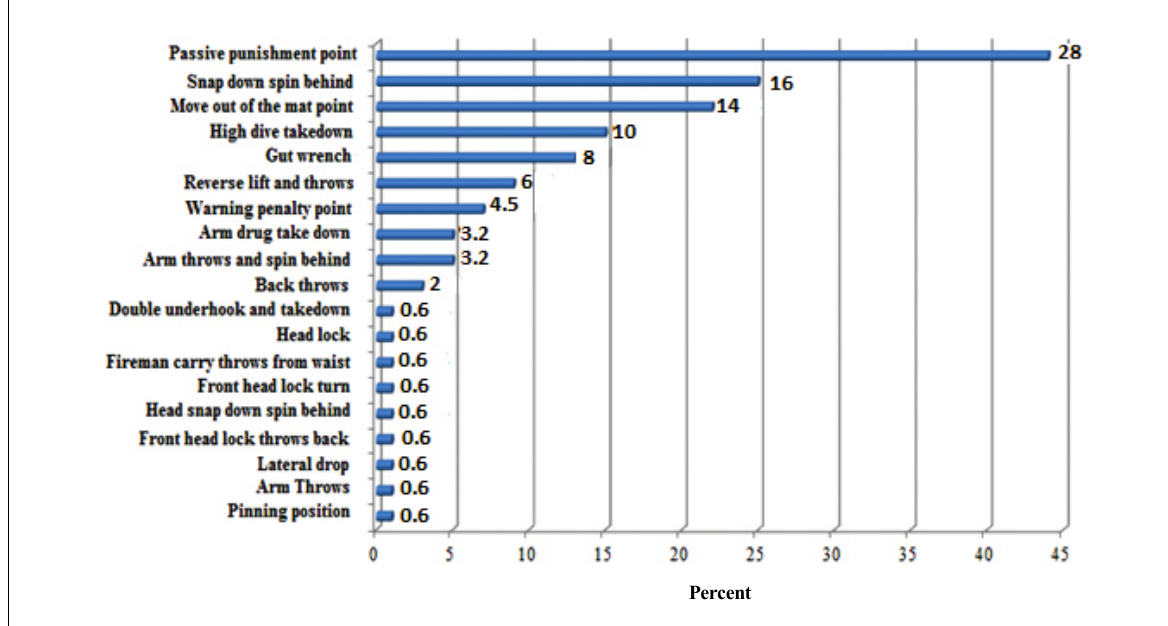
Figure 1. The percentage distribution of successful techniques made by lightweight wrestlers